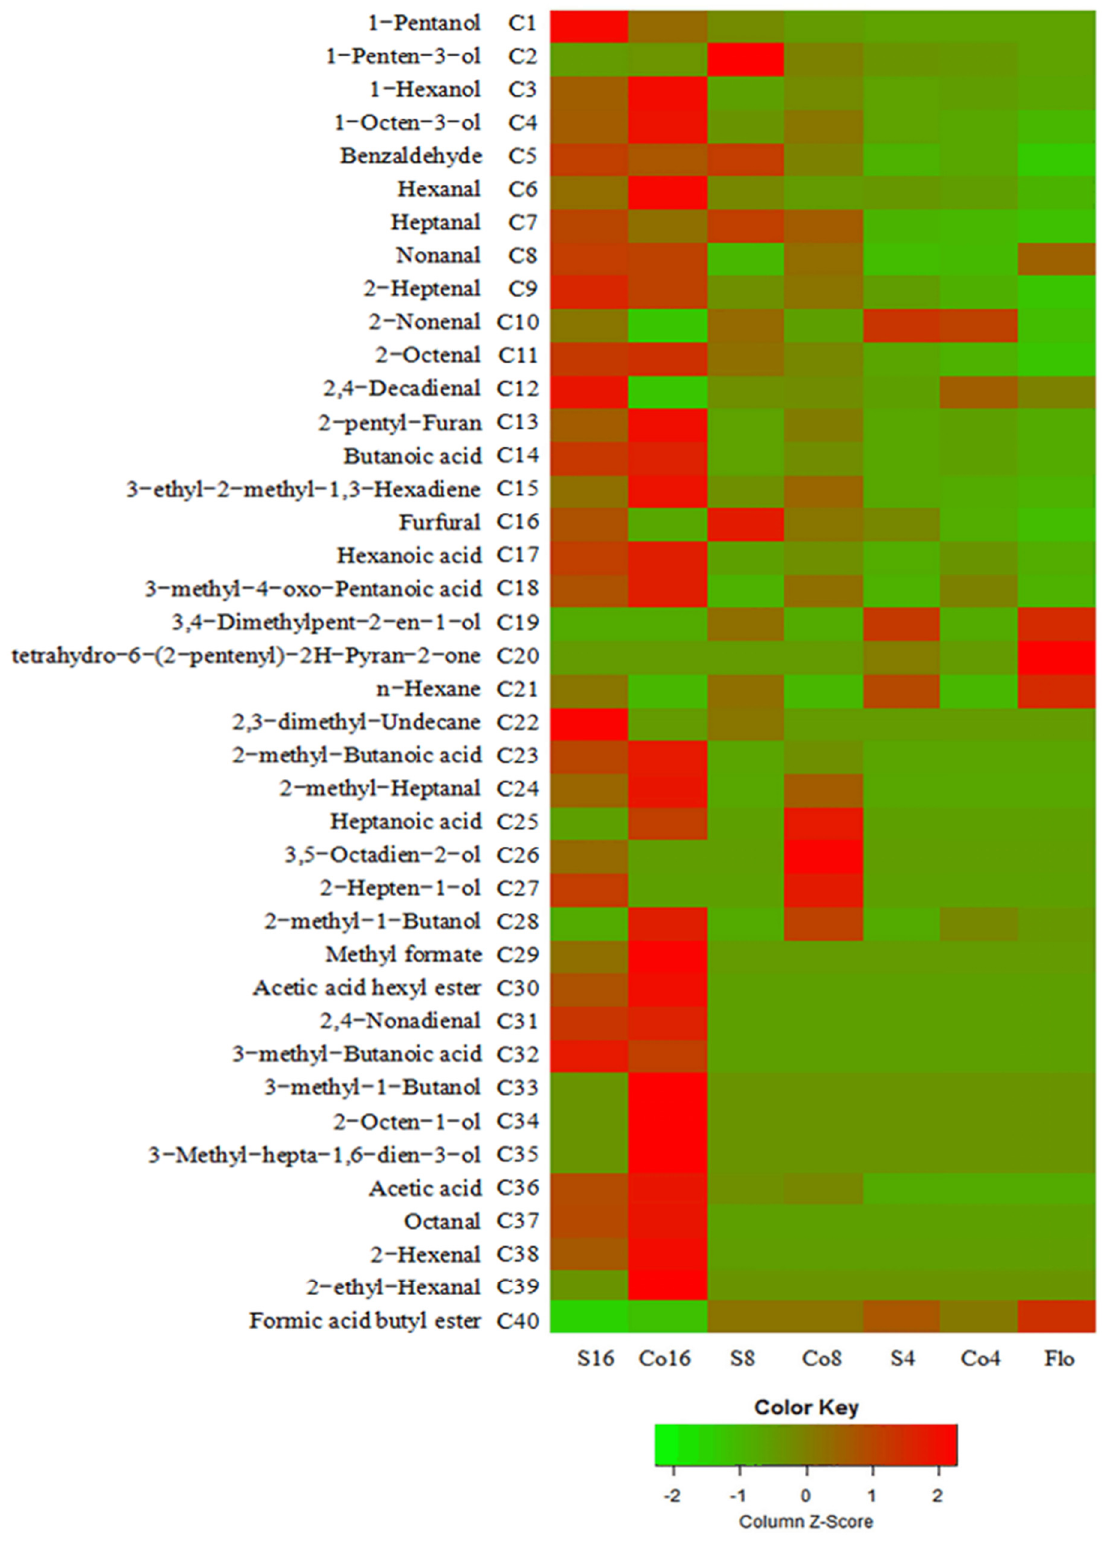
Figure 4. Heatmap of VOC in sourdough. Flo indicating fresh dough. Co4, Co8 and Co16 indicating wholewheat sourdough fermented for 4, 8 and 16 h, respectively. S4, S8 and S16 indicating whole- wheat sourdough artificial contaminated with S. aureus (10 2 cfu/g) and cultured for 4, 8 and 16 h, respectively ( n = 6).